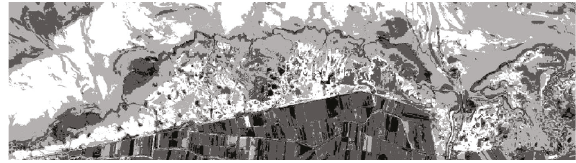
Figure 15: The vote map.